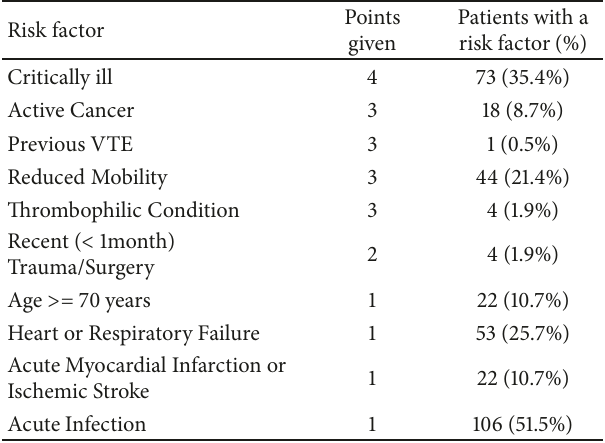
Table 2: Risk factors for thromboembolism among study